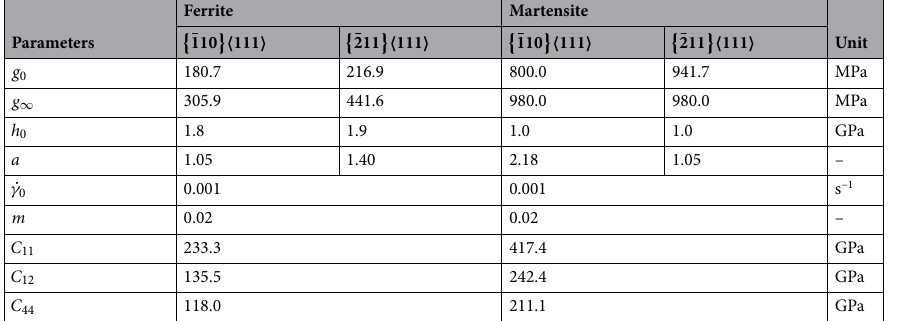
Table 1. Material parameters adjusted to the mechanical properties of both ferrite and martensite phases. Parameters of the initial and saturation slip resistances, reference self-hardening modulus, and hardening exponent were determined by an in-house inverse simulation procedure based on the experimental data; other parameters were routinely documented and referred to the literature 35 .